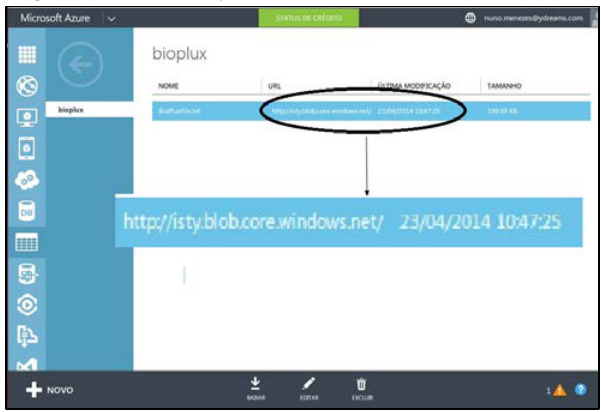
Figure 8. Azure Interface (showing that a file was uploaded to the cloud at specific time instant).